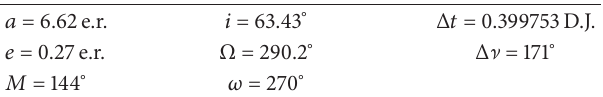
Table 2: Orbital elements and temporal distance between ⃗𝑟 1 and ⃗𝑟 2 . Tundra